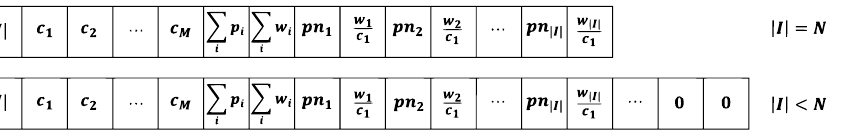
Figure 1. State of multiple knapsack